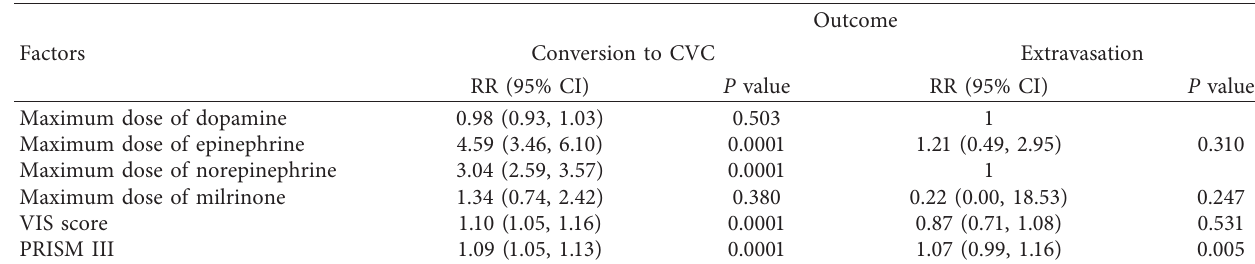
Table 3: Univariate